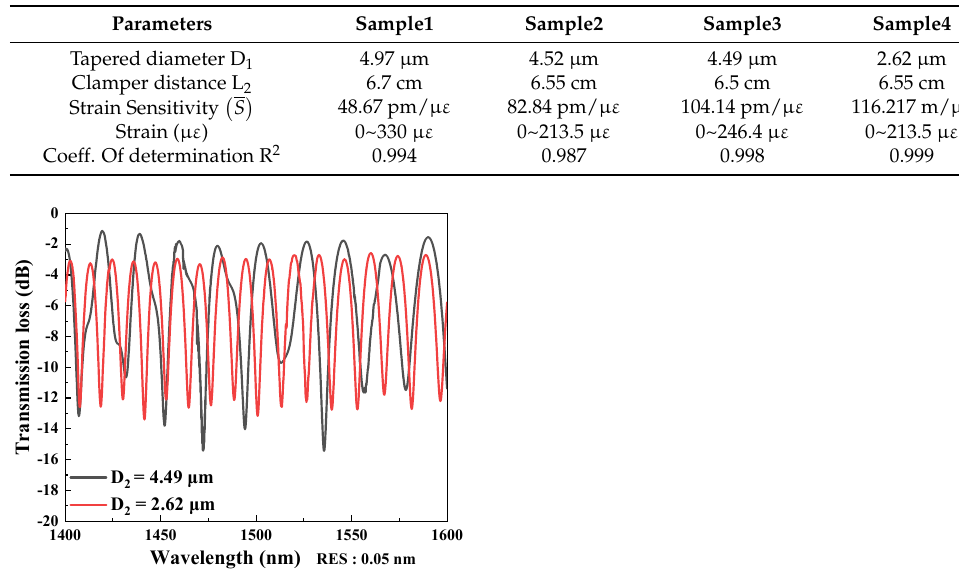
µ m and 4.49 µ 2 = 2.62